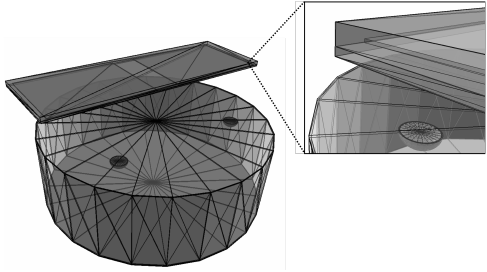
Figure 2. Visualization of both the SSD and WCD volumes de- fined in the Geant4-based simulation application with a close-up of one corner of the